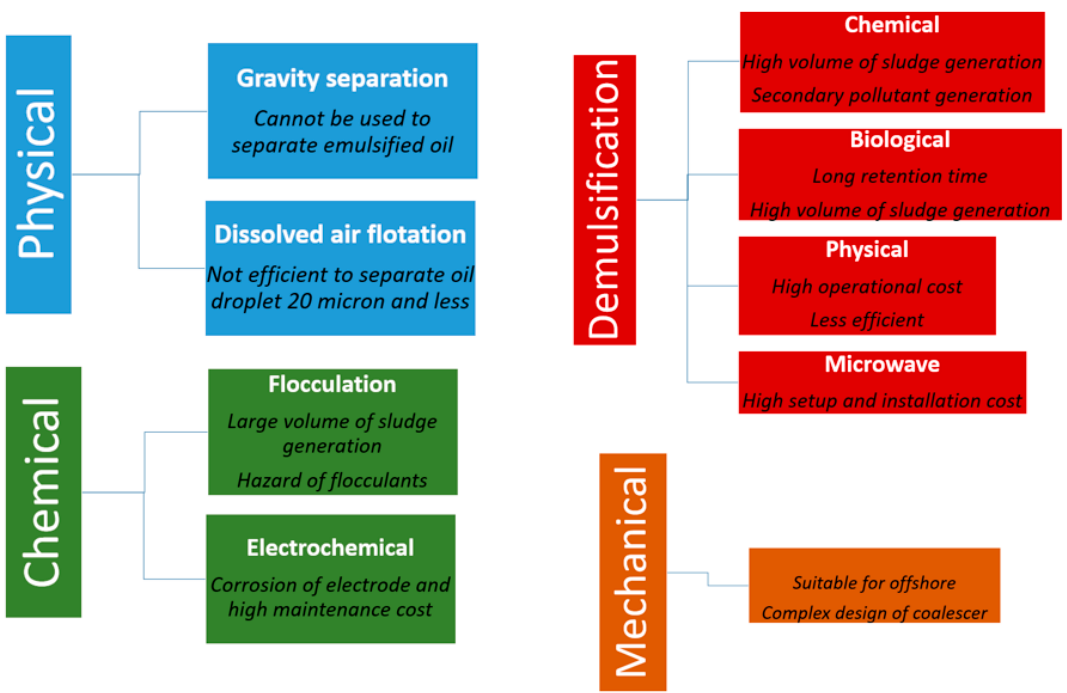
Figure 7. Limitation of conventional oily wastewater cleaning methods.